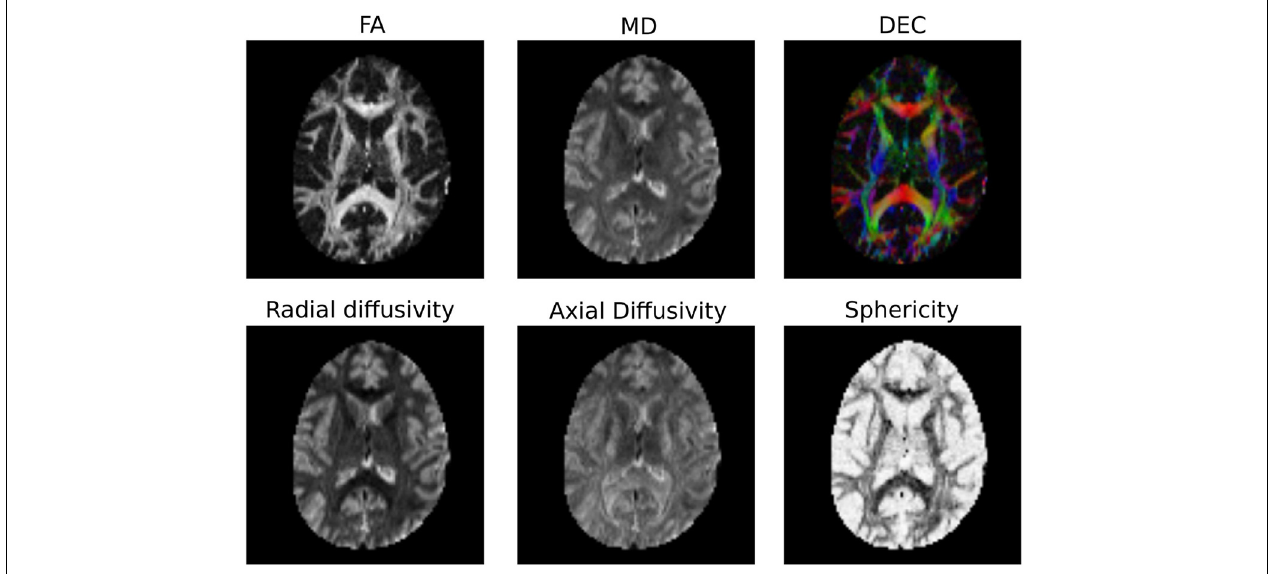
FIGURE 4 | Diffusion Tensor based scalar maps created with